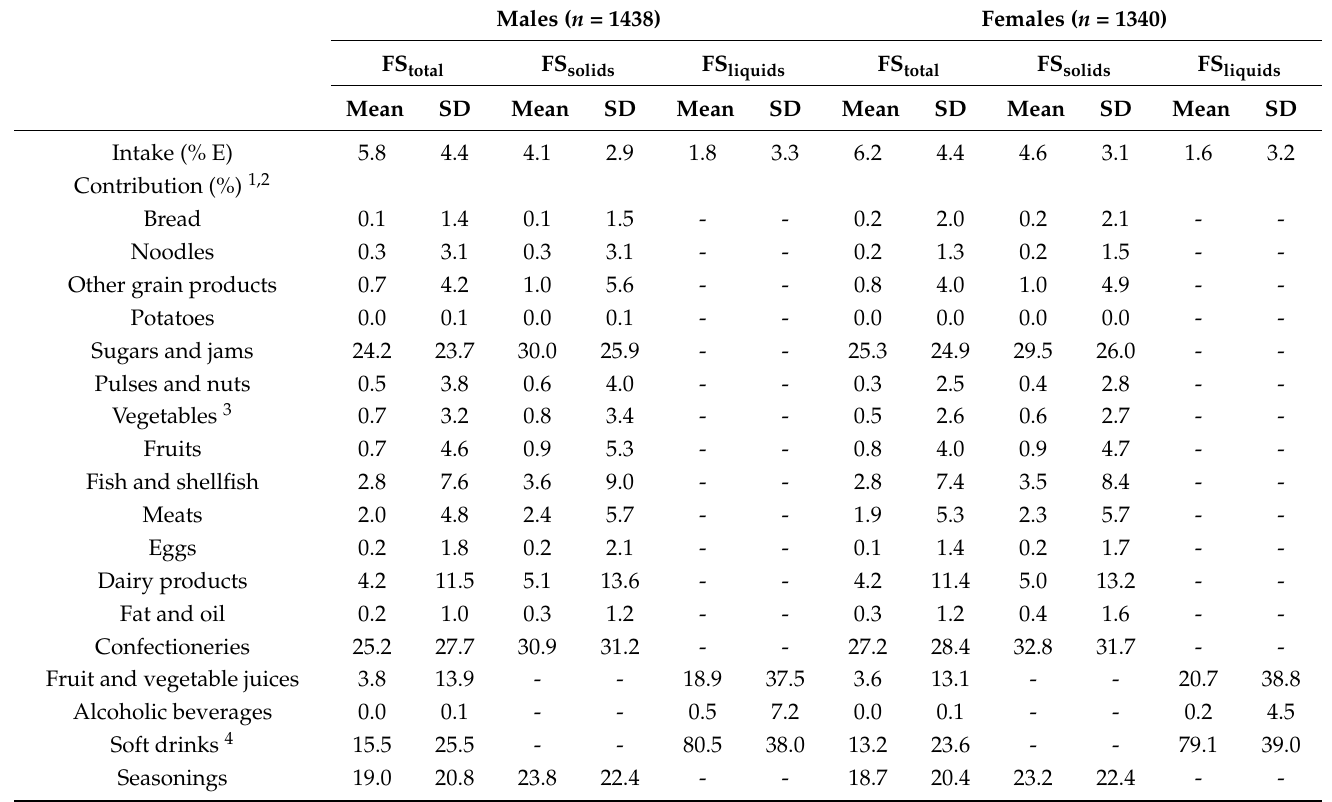
Table 1. Contribution (%) of each food group to free sugars intake in Japanese children and adoles- cents aged 2–19 years: the 2016 National Health and Nutrition Survey, Japan. Males ( n =